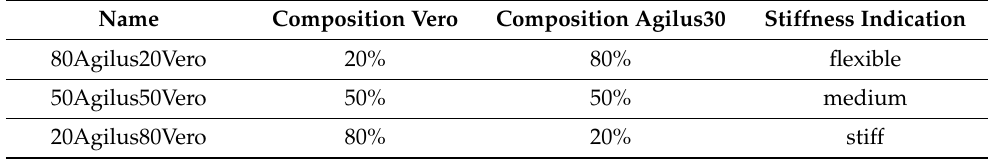
Table 1. Ratios of the different material mixtures used for the diaphragms in the prototypes.